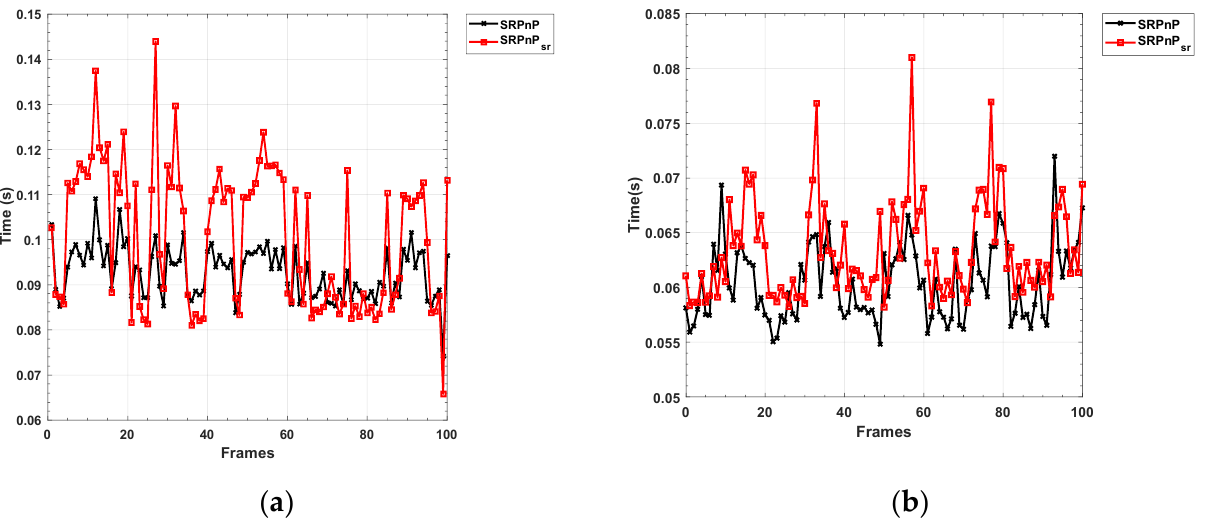
Figure 19. Comparison of detection speeds of each frame image ( a ) The operating speed of algorithm in 5 m; ( b ) The operating speed of algorithm in 10–5 m.